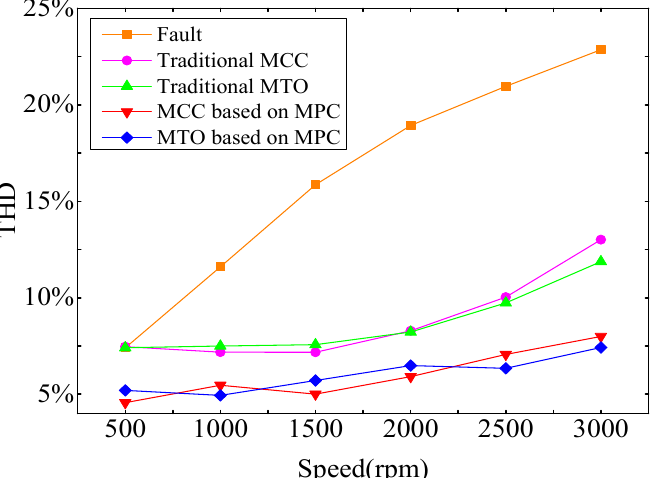
Figure 11. THD of motor torque.